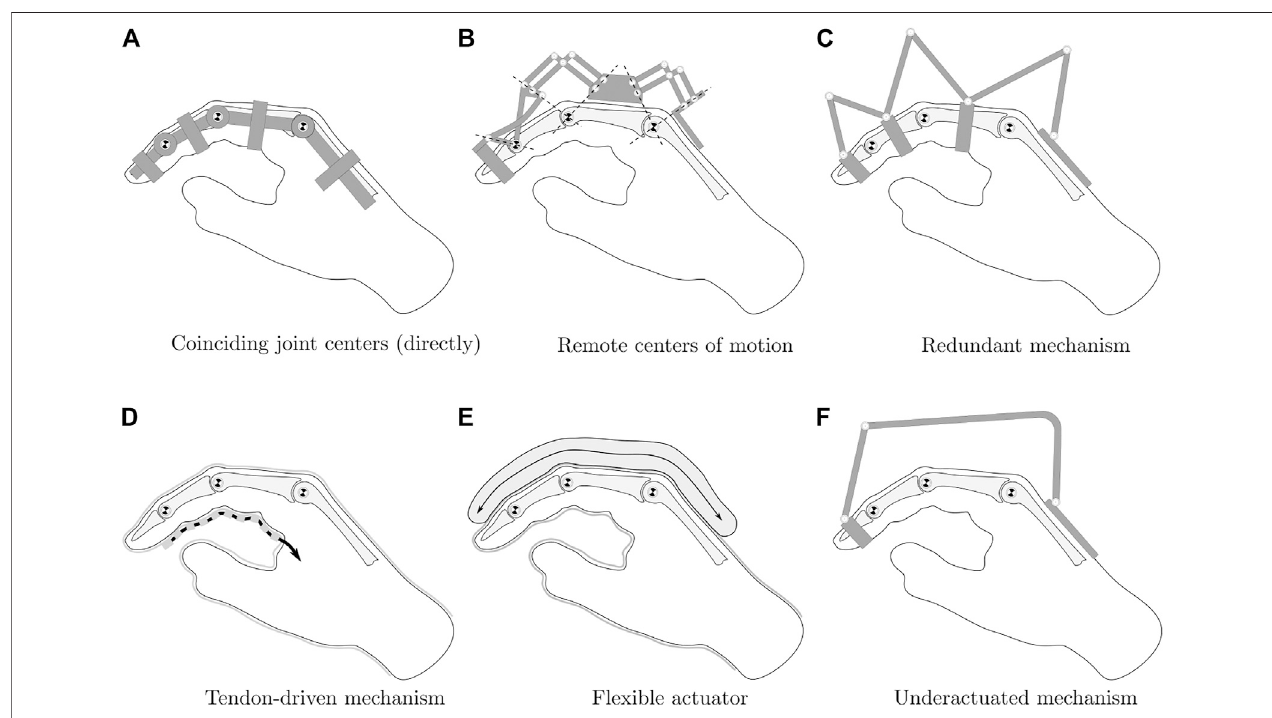
FIGURE 1 | Hand exoskeleton kinematic options, modi fi ed from Heo et al. (2012).